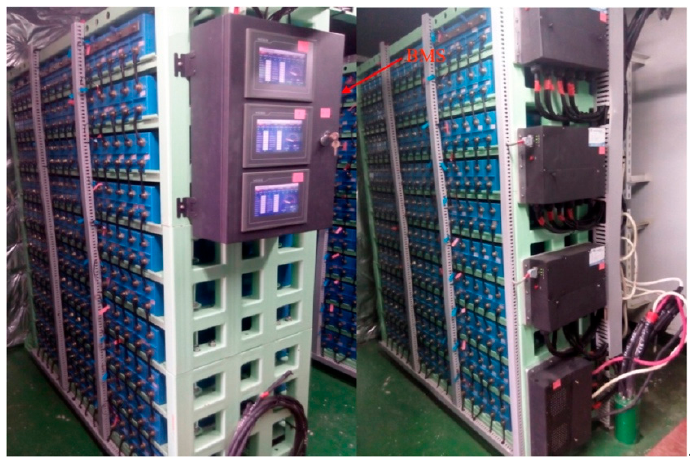
Figure 3. Battery energy storage system.